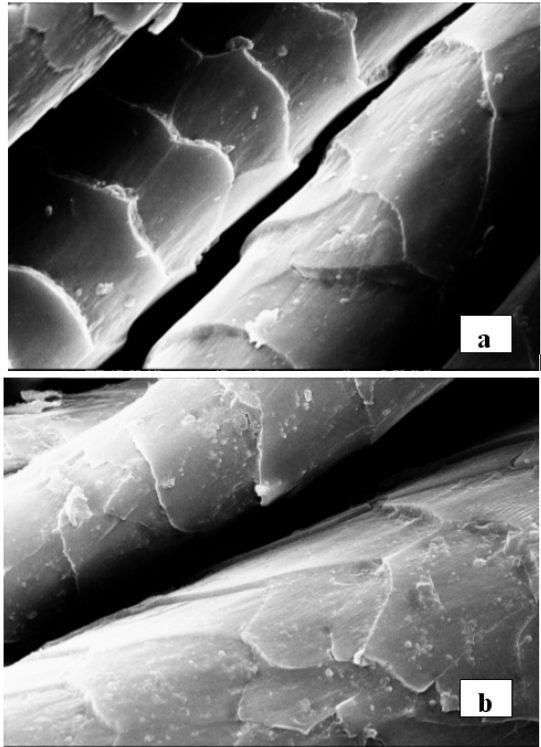
Figure 4. SEM images of wool fibers dyed at 85°C: a) without enzyme, b) with enzyme. Magnification ratio 2,500x.